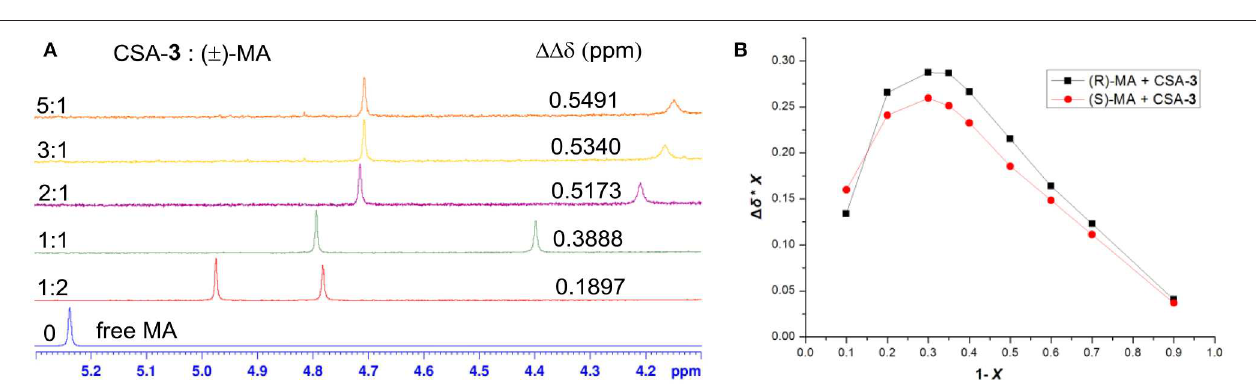
Table 1 . Because of the multiple hydrogen–bond interactions of OH/NH moiety and incorporated anisotropic